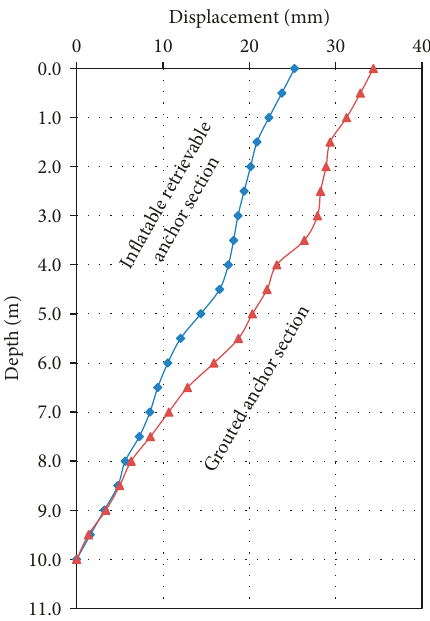
Figure 11: Horizontal displacement of two